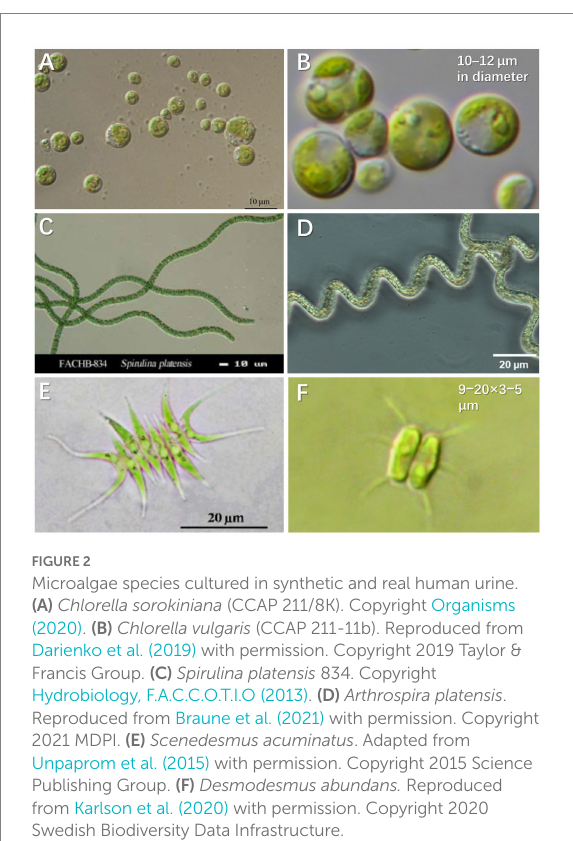
FIGURE 2 Microalgae species cultured in synthetic and real human urine. (A) Chlorella sorokiniana (CCAP 211/8K). Copyright Organisms (2020). (B) Chlorella vulgaris (CCAP 211-11b). Reproduced from Darienko et al. (2019) with permission. Copyright 2019 Taylor & Francis Group. (C) Spirulina platensis 834. Copyright Hydrobiology, F.A.C.C.O.T.I.O (2013). (D) Arthrospira platensis . Reproduced from Braune et al. (2021) with permission. Copyright 2021 MDPI. (E) Scenedesmus acuminatus . Adapted from Unpaprom et al. (2015) with permission. Copyright 2015 Science Publishing Group. (F) Desmodesmus abundans. Reproduced from Karlson et al. (2020) with permission. Copyright 2020 Swedish Biodiversity Data